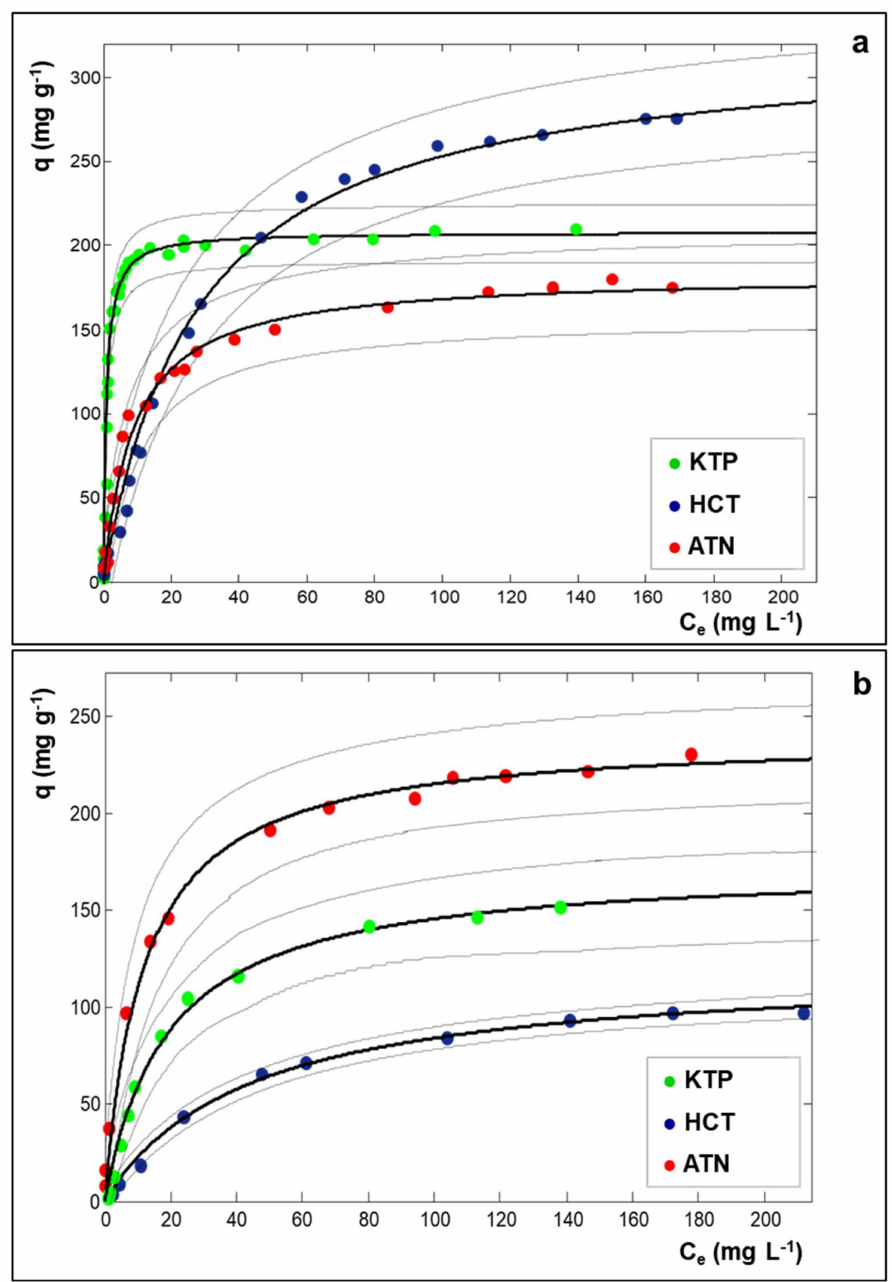
Figure 1. Adsorption isotherms of ketoprofen (KTP: green symbols), hydrochlorothiazide (HCT: dark blue symbols), and atenolol (ATN: red symbols) on Y200 ( a ) and Y30 ( b ) in Milli-Q water. Dotted lines are the confidence limits at 95% of probability of the fitted